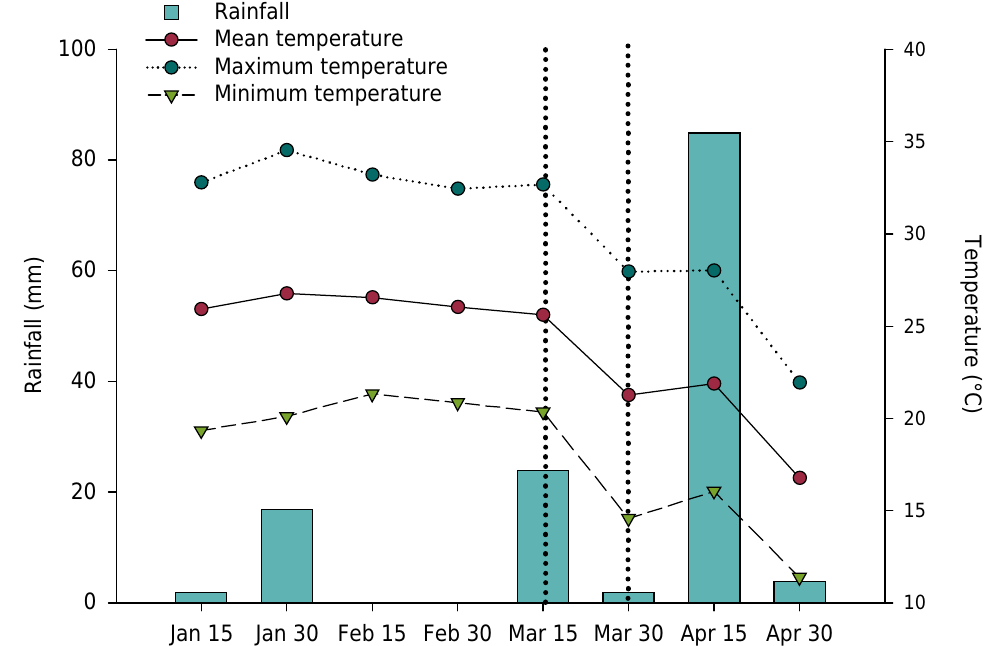
Figure 1. Accumulated rainfall and the mean, maximum, and minimum air temperature in 15-day intervals throughout the months of the study in São Gabriel, RS, Brazil. The time-period between dotted lines corresponds to sampling